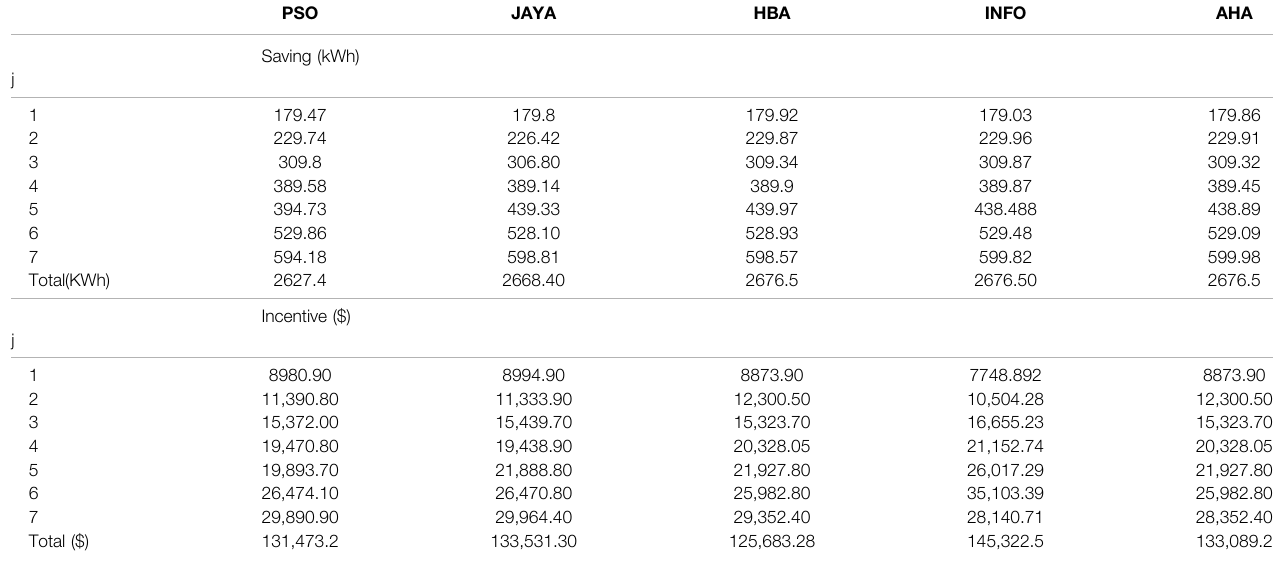
TABLE 10 | Total amount of energy saved and the total amount of incentive received (case study 2).